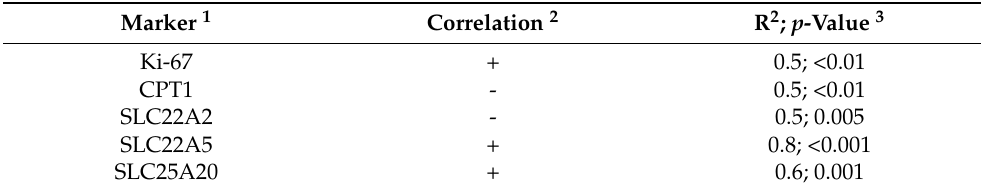
Figure 5. [ 18 F]FPIA uptake in relation to tumor proliferation and lipid metabolism-associated proteins in subcutaneous HSJD-GBM-001 and U87 glioma xenografts. Tumor proliferation (Ki-67) and the expression of lipid metabolism-associated proteins (CPT1, SLC22A2, SLC22A5, SLS25A20) were assessed using immunohistochemistry. ( a ) Representative images of marker expression in HSJD-GBM-001 tumors (50 µm), ( b ) Correlation between [ 18 F]FPIA tumor uptake and marker expression in both HSJD-GBM-001 and U87 tumors, ( c ) Tumor proliferation and lipid metabolism-associated protein expression in response to etomoxir treatment were assessed. Treatment with etomoxir significantly decreased Ki-67 and increased CPT1 expression in HSJD-GBM-001 tumors (* p < 0.05 and p = 0.0001, 2-way ANOVA, respectively), and decreased SLC22A5 expression in U87 tumors (* p < 0.05, 2-way ANOVA). Table 1. Summary of [ 18 F]FPIA tumor uptake correlations with proliferation and lipid metabolism- associated